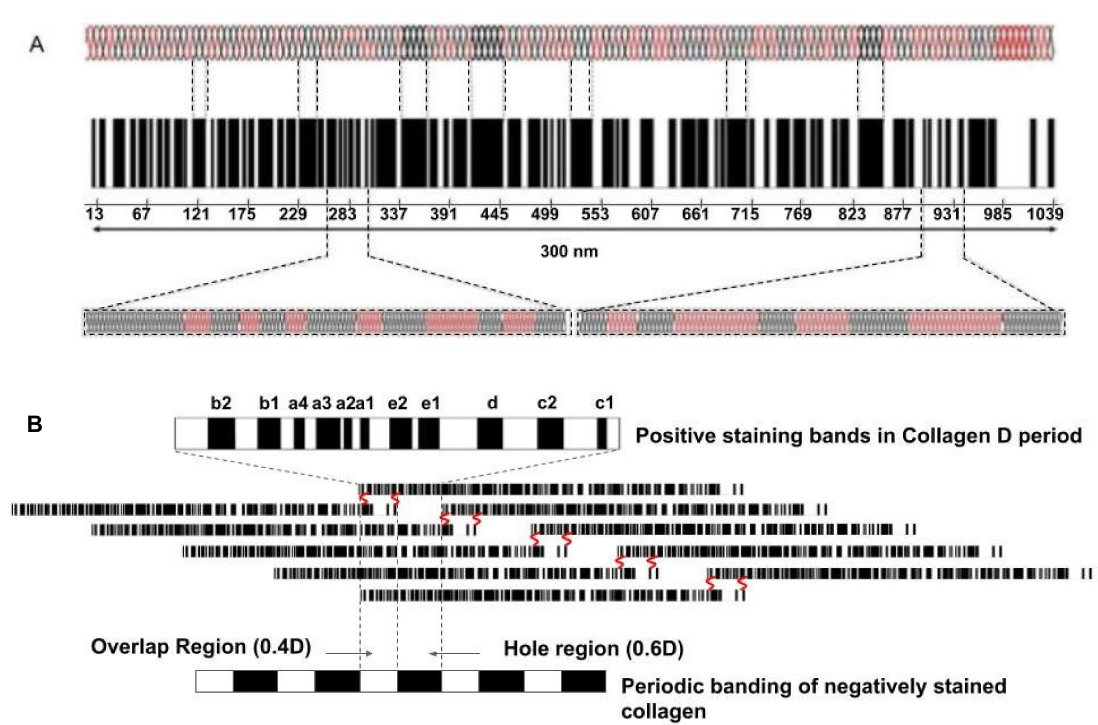
Figure 10. A model depicting the collagen molecule composed of rigid (black) and flexible (red) regions ( A ) and a quarter-staggered array of 5 molecules packed laterally that make up the microfibril ( B ) in the tendon. The numbers under the molecular bar code illustrated in A are the amino acid residue numbers. The flexible and rigid regions shown in A are blown up below the bar code. Initially, under stress the red regions of the molecule are stretched. The banding pattern of the collagen D period is shown in B. The bands a through e represent the positively staining bands characteristic of collagen fibrils seen by electron microscopy that arise from alignment of all the flexible regions in the collagen molecules. The negatively staining bands, showing the hole and overlap regions at the bottom of B, illustrate the penetration of stain into the region of the microfibril devoid of amino